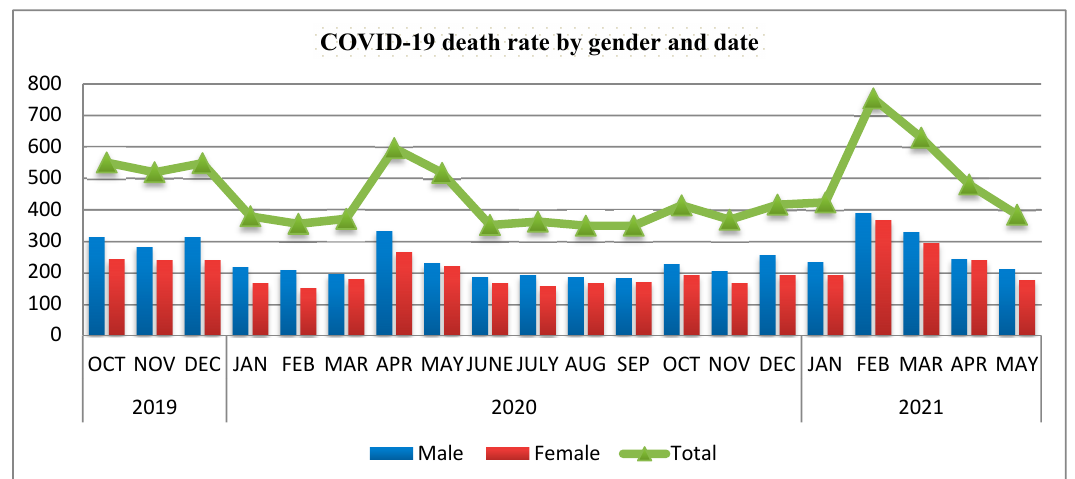
Figure 2. Number of people buried in Mogadishu Cemetery (Heliwa District) during COVID-19